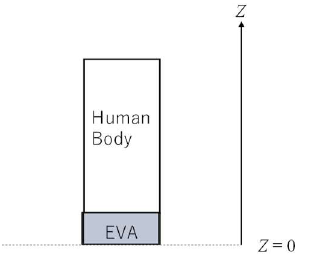
Figure 1. One-dimensional coordinate system used in the proposed thermal analyses